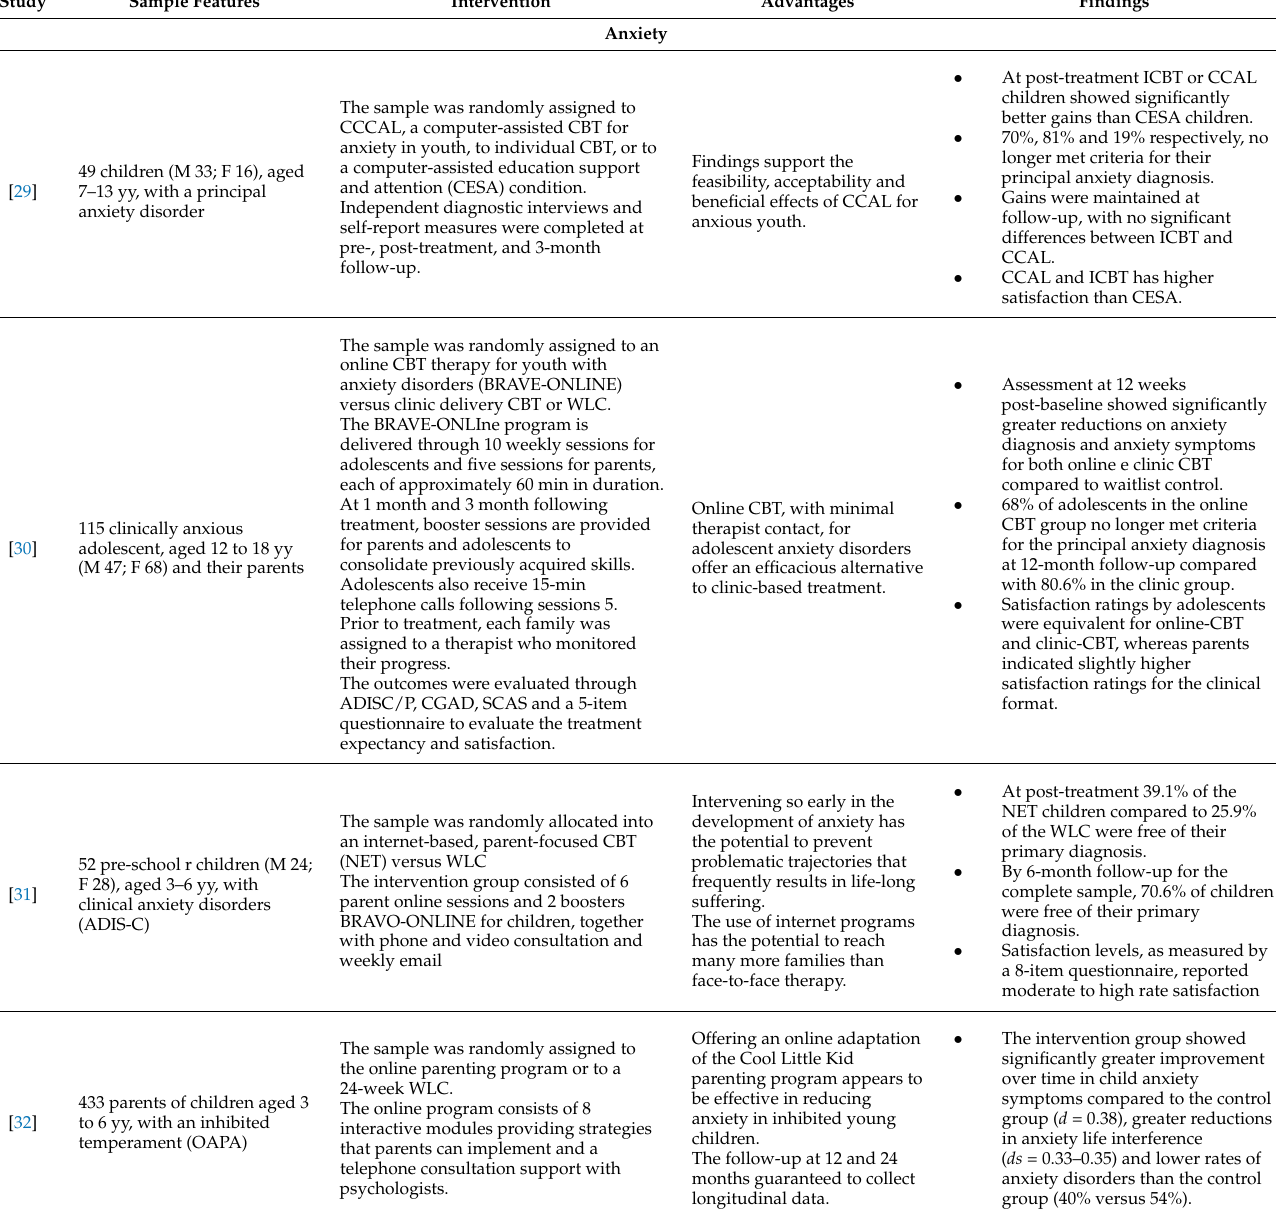
Table 2. Summary of retrieved